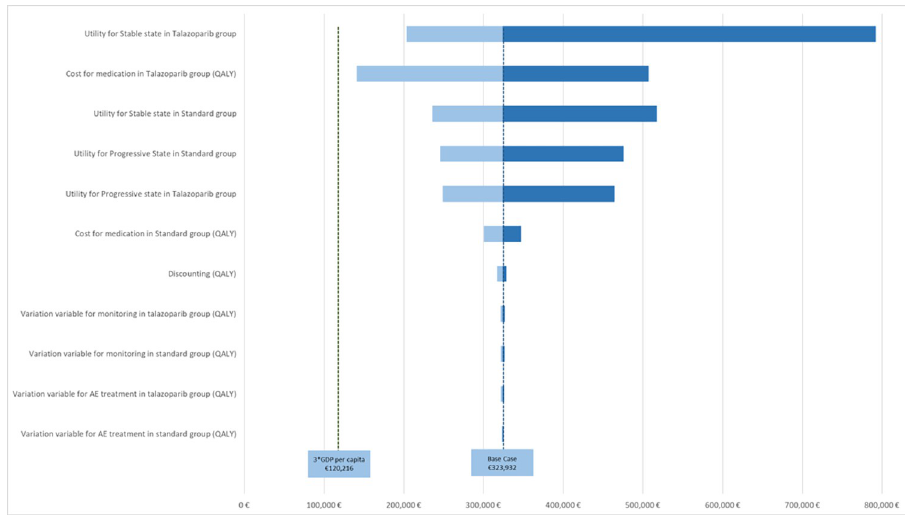
Fig 2. Scenario analysis. QALY = quality-adjusted life year, AE = adverse event, GDP = gross domestic product.